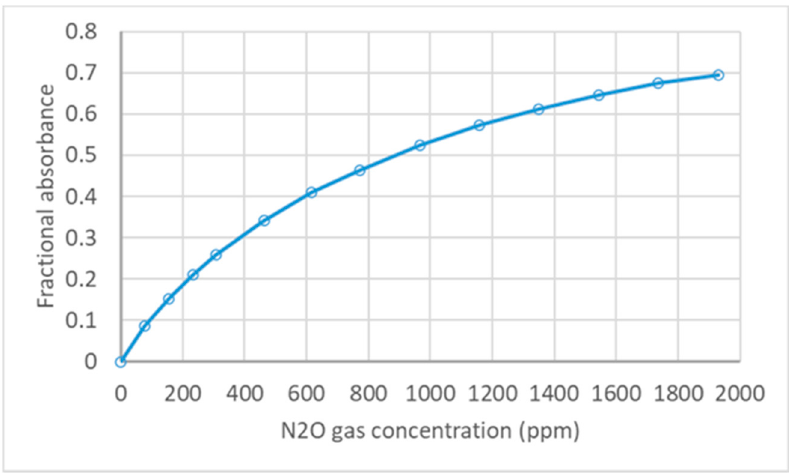
Figure 4. Nondispersive infrared (NDIR) fractional absorbance at each N 2 O gas concentration level.